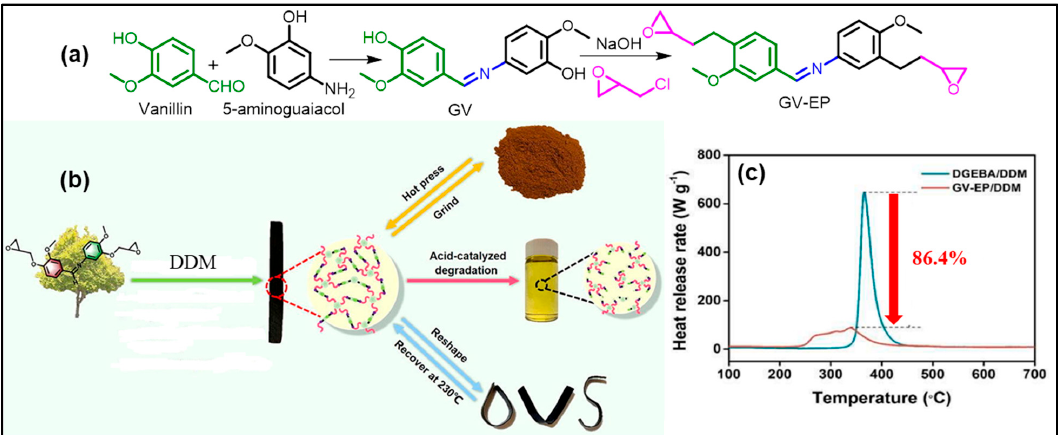
Figure 6. ( a ) Synthesized of greener Schiff-base epoxy monomer (GV-EP); ( b ) curing process and its physical reprocessing, chemical degrading and reshaping performance; ( c ) pHRR versus temperature curve for the developed and control thermosets from the cone calorimeter test [reproduced with